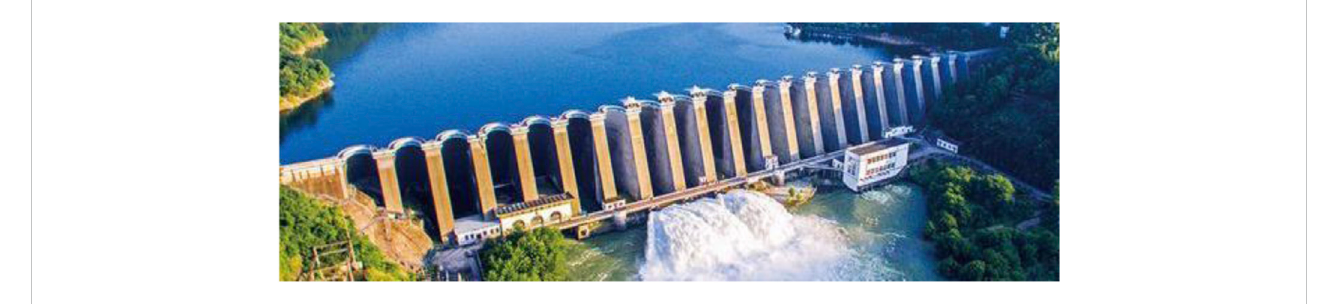
FIGURE 6 Layout of the multiple-arch dam.